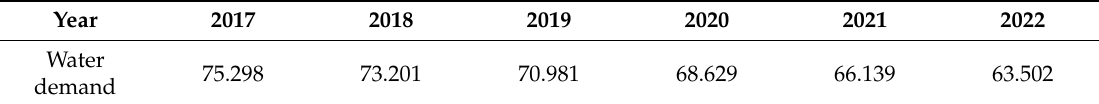
Table 5. Prediction data of the water demand in Chongqing from 2017 to